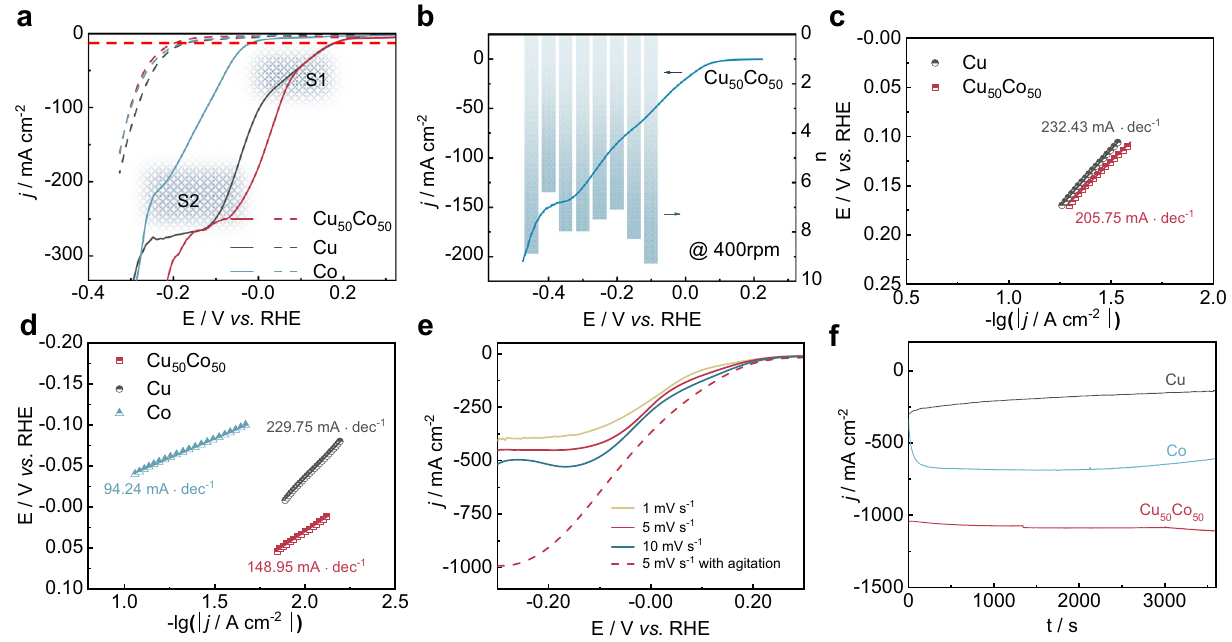
Fig. 2 | Electrochemicalresponses ofCu 50 Co 50 , pureCu, andpure Co catalysts. a j - E curve (80% i R corrected) over Cu 50 Co 50 , pure Cu, and pure Co modi fi ed Ni foams (catalysts loading was 5mgcm − 2 ) in 1M KOH solution containing 100mM KNO 3 (solid lines) or in the absence of KNO 3 (dotted line) at a scan rate of 1mVs − 1 (the red dash line presenting the j of 10mAcm − 2 , the shading S1 and S2 presenting thepeakaround0.2to0.05Vand0.05to − 0.15V,respectively). b j - E curve(80%i R corrected) at 400 rpm and electron transfer numbers at different potentials cal- culated by the K – L equation for Cu 50 Co 50 on RDE in 100mM KNO 3 +1M KOH